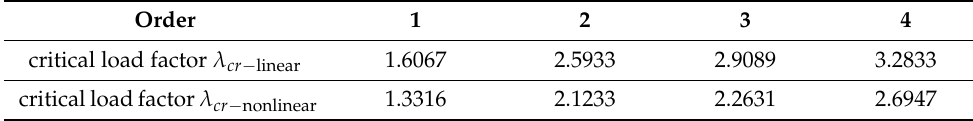
Table 3. The critical load factor of the first four